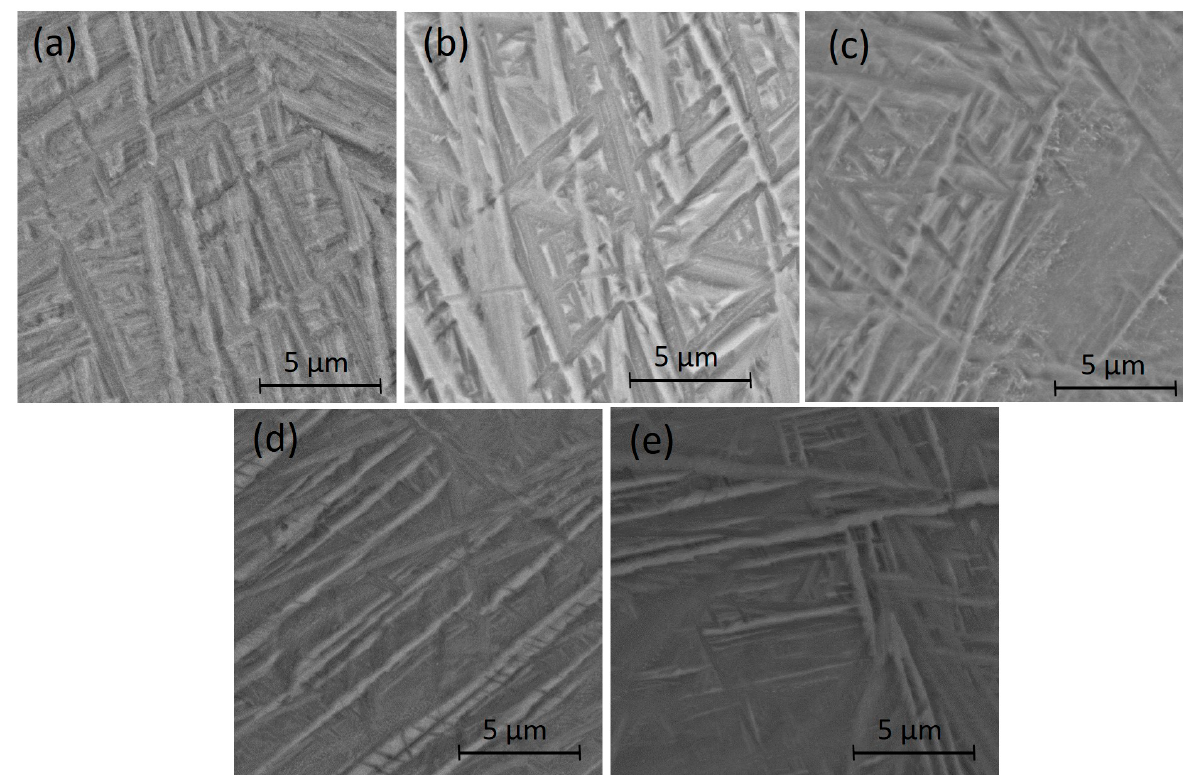
Figure 5 . Weld zone micrographs of various welds: ( a ) 2.0 mm equiaxed grain plate welded at 2.0 m min − 1 , 2.4 kW; ( b ) 5.8 mm equiaxed grain plate welded at 1.5 m min − 1 , 4 kW; ( c ) 5.8 mm equiaxed grain plate welded at 2.0 m min − 1 , 4 kW; ( d ) 3.0 mm lamellar grain plate welded at 2.0 m min − 1 , 2.8 kW; ( e ) 3.8 mm lamellar grain plate welded at 2.0 m min − 1 , 2.8 kW.